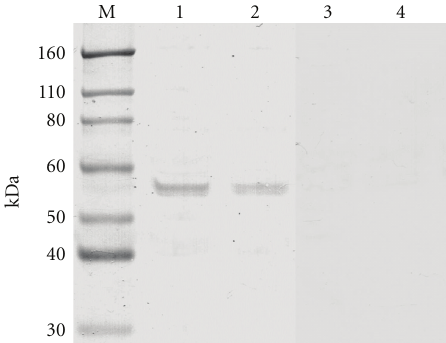
Figure 2: Representative western blots for the H1 receptor protein in human nasal mucosa (lane 1: perennial allergic nasal mucosa, lane 2: nonallergic nasal mucosa). The antibody recognized a single protein of 56kDa referred as H1 receptor. In control experiments, anti-H1 receptor antibody was preincubated with specific blocking peptides (lane 3: control for lane 1, lane 4: control for lane 2).